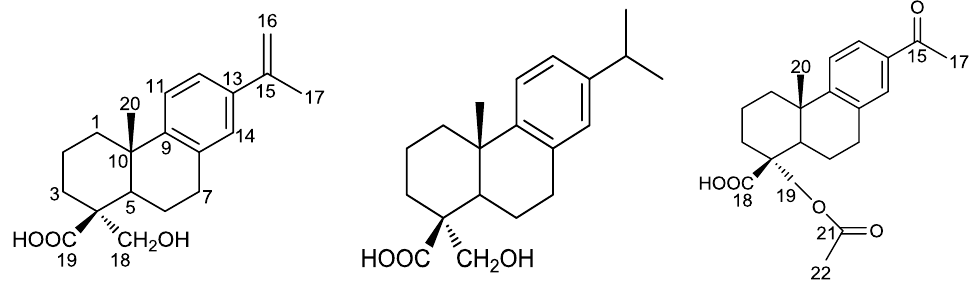
Figure 1. The structures of compounds 1 to 3 .